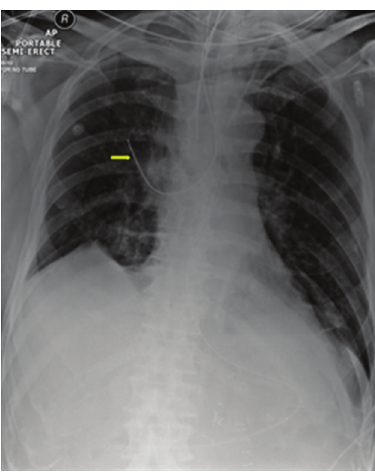
Figure 37: The tip of the NGT has entered the right upper lobe